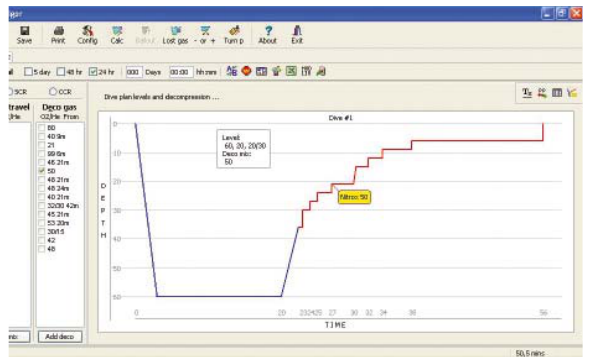
Fig. 2. The graph of the prepared dive plan for performed dives at 60 m of depth and used combination of breathing mixtures; Produced using V - Planner scuba diving decompression planning software and used for all present